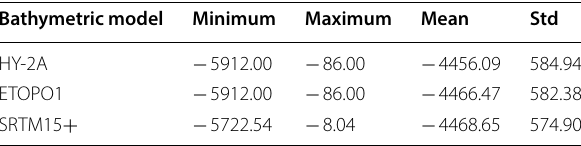
Table 8 Statistics of bathymetry models from HY-2A, ETOPO1 and SRTM15 (unit: m) +